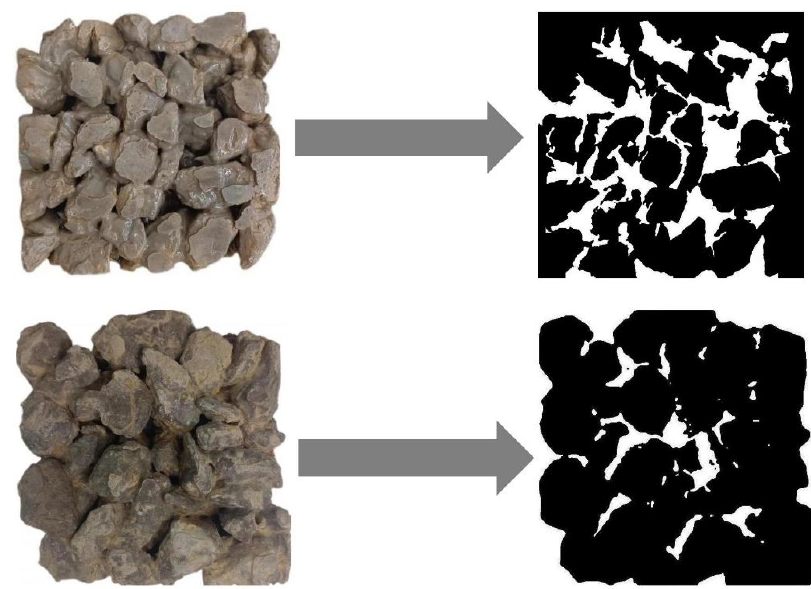
Figure 2. Image Figure 2. Image processing.